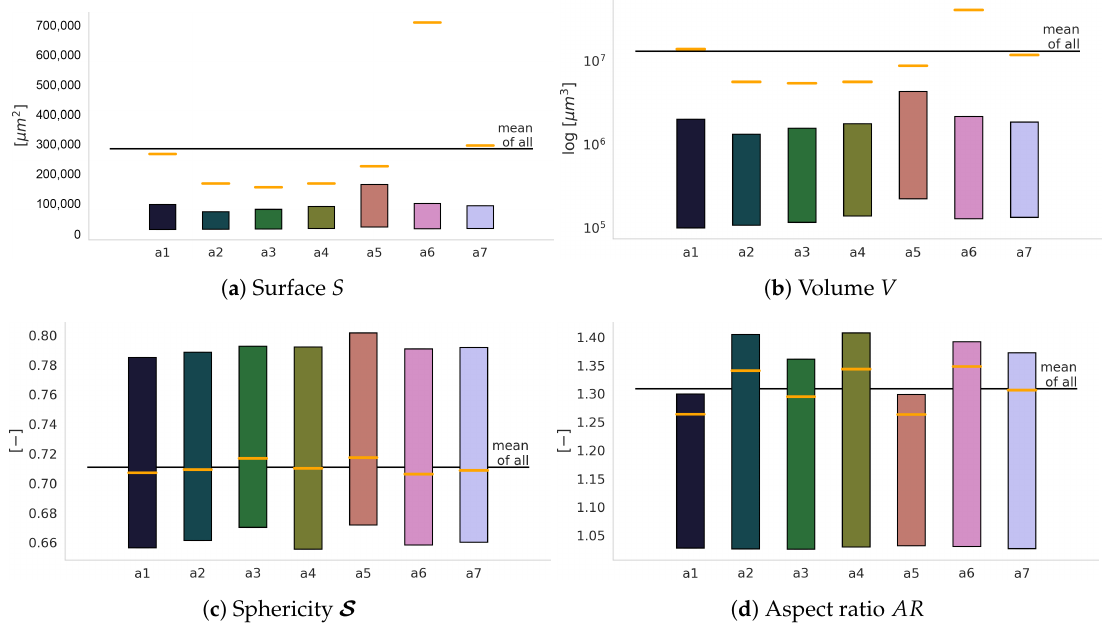
Figure 6. Comparison of the mean values of the geometric features of defects in specimens a1–a7: ( a ) Surface S ; ( b ) Volume V ; ( c ) Sphericity S ; ( d ) Aspect ratio AR . The mean values for all the characterized defects are also included for